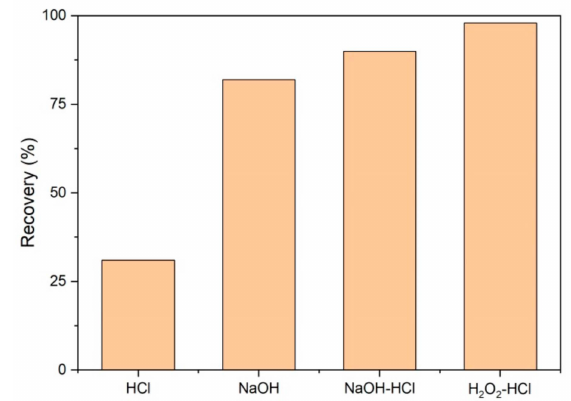
Figure 9. The cleaning effects of UF